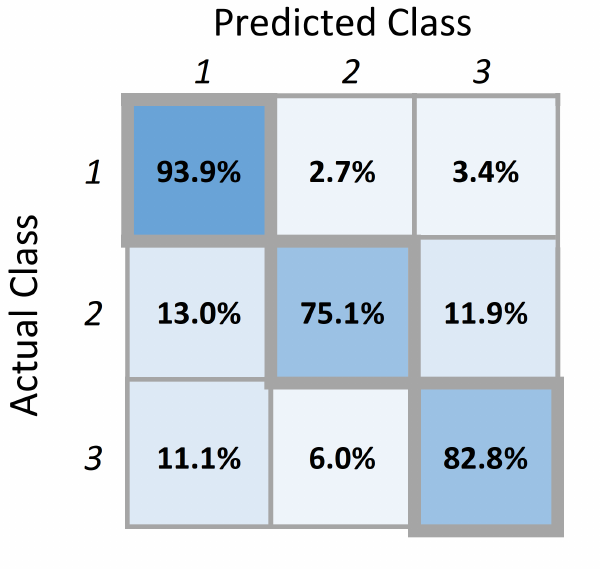
Figure 18. Confusion matrix from the evaluation with Multiclass Neural Network (500 nodes hidden layer, learning rate 0.1, 1000 learning